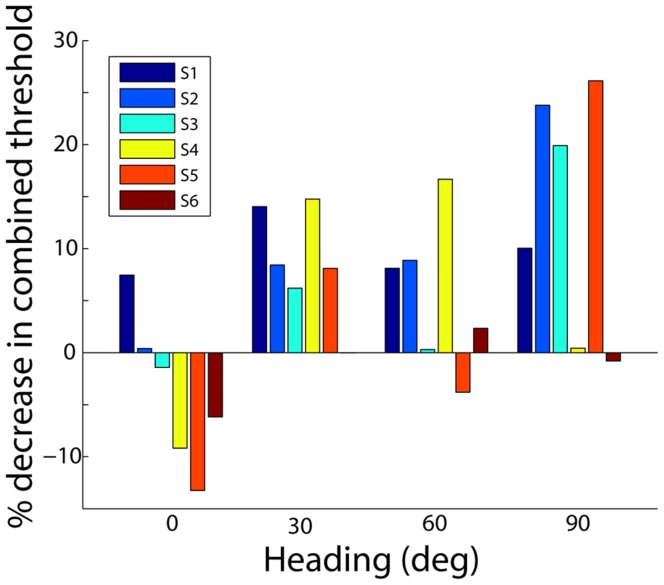
Comparison of visual-only and combined thresholds.Percent decrease in combined threshold relative to the visual-only threshold (computed as (
σ
v -
σ
c)/
σ
v; subjects S1-S6) for all four heading angles. The decrease in threshold depends on heading angle, with the smallest decrease for 0° heading and the largest decrease for 90° heading.